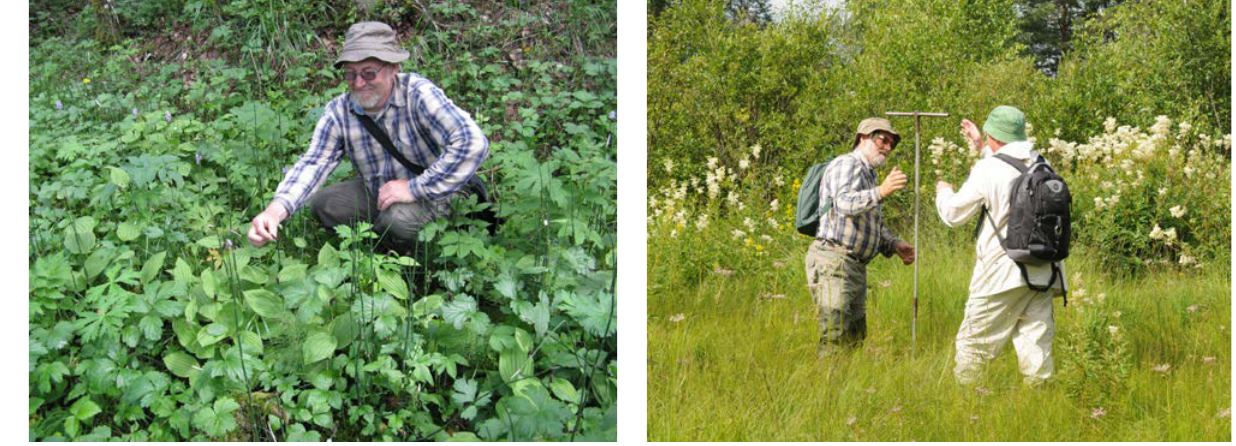
Figure 10. Oleg Kuzetsov in a luxuriant thin-peated rich fen with e.g. Cypripedium calceolus in Mire 36 in 2008 (photo: Raimo Heikkilä).